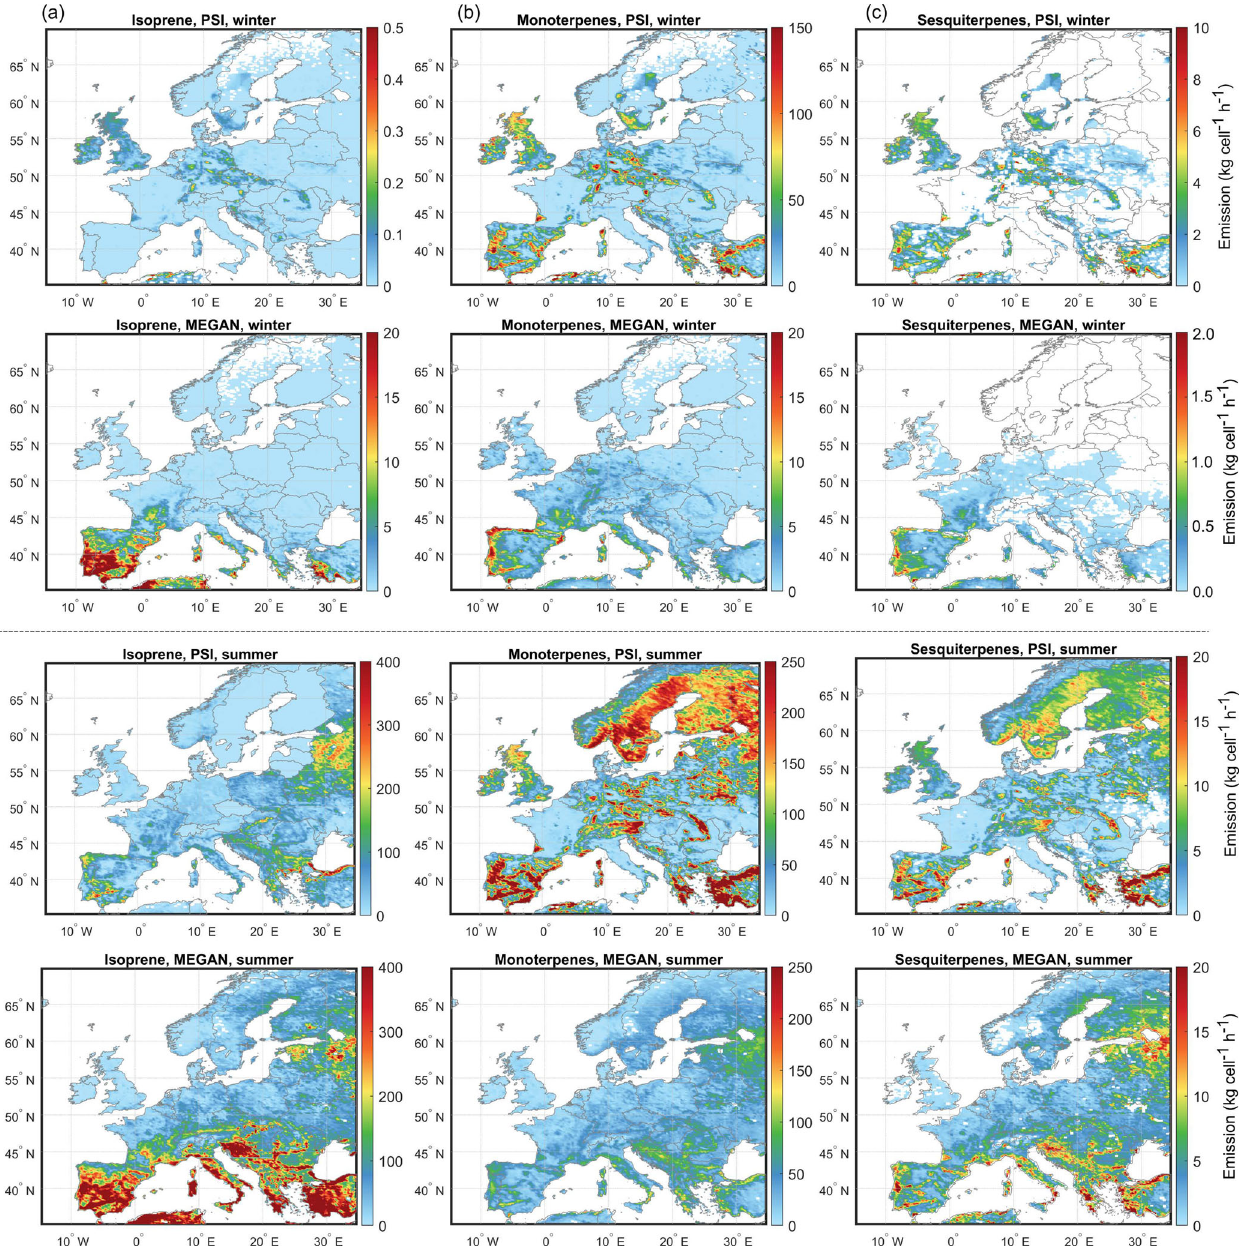
Figure 2. Average hourly emissions of isoprene (a) , monoterpenes (b) , and sesquiterpenes (c) estimated by the PSI model and MEGAN2.1. The upper and lower panels represent winter and summer cases,